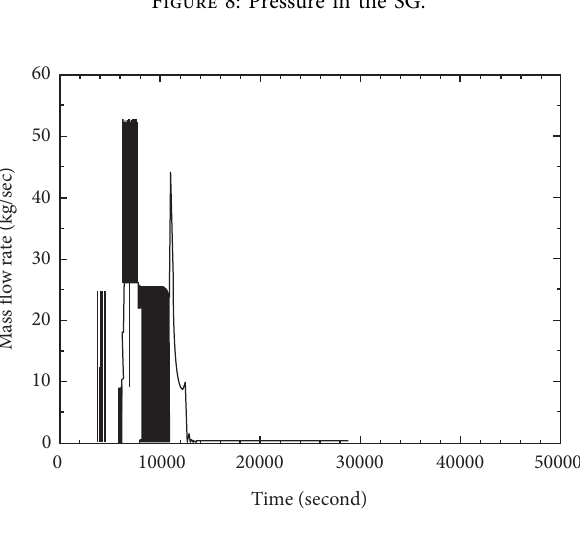
Figure 8: Pressure in the SG.